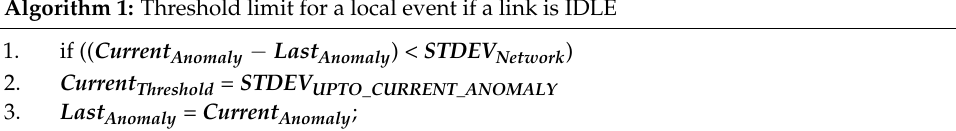
Algorithm 1: Threshold limit for a local event if a link is IDLE